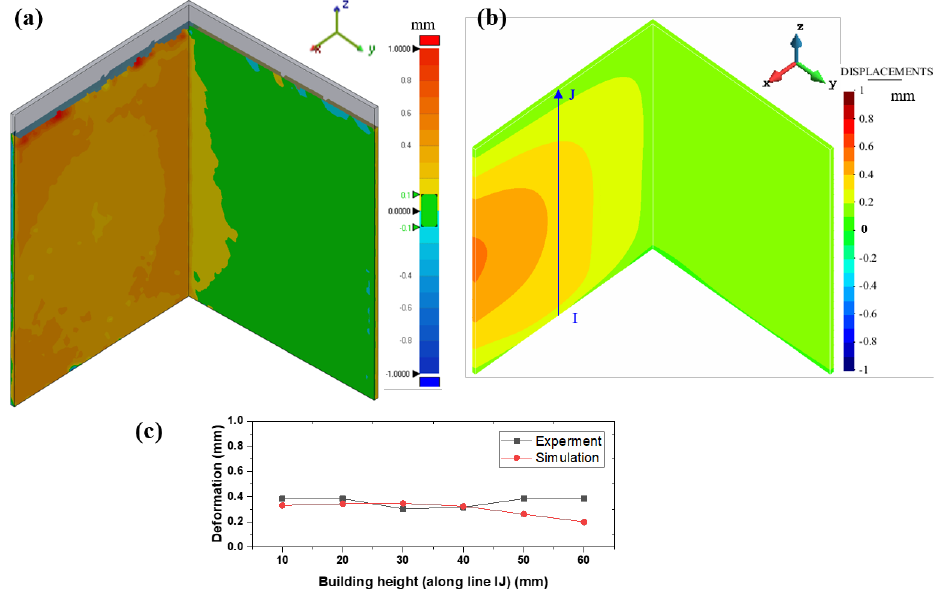
Figure 11. L − shape (L2) part: comparison between the ( a ) experimental and ( b ) simulated displace- ment distributions. ( c ) The deformation distribution along the line IJ located at the center of the inner surfaces of the build.